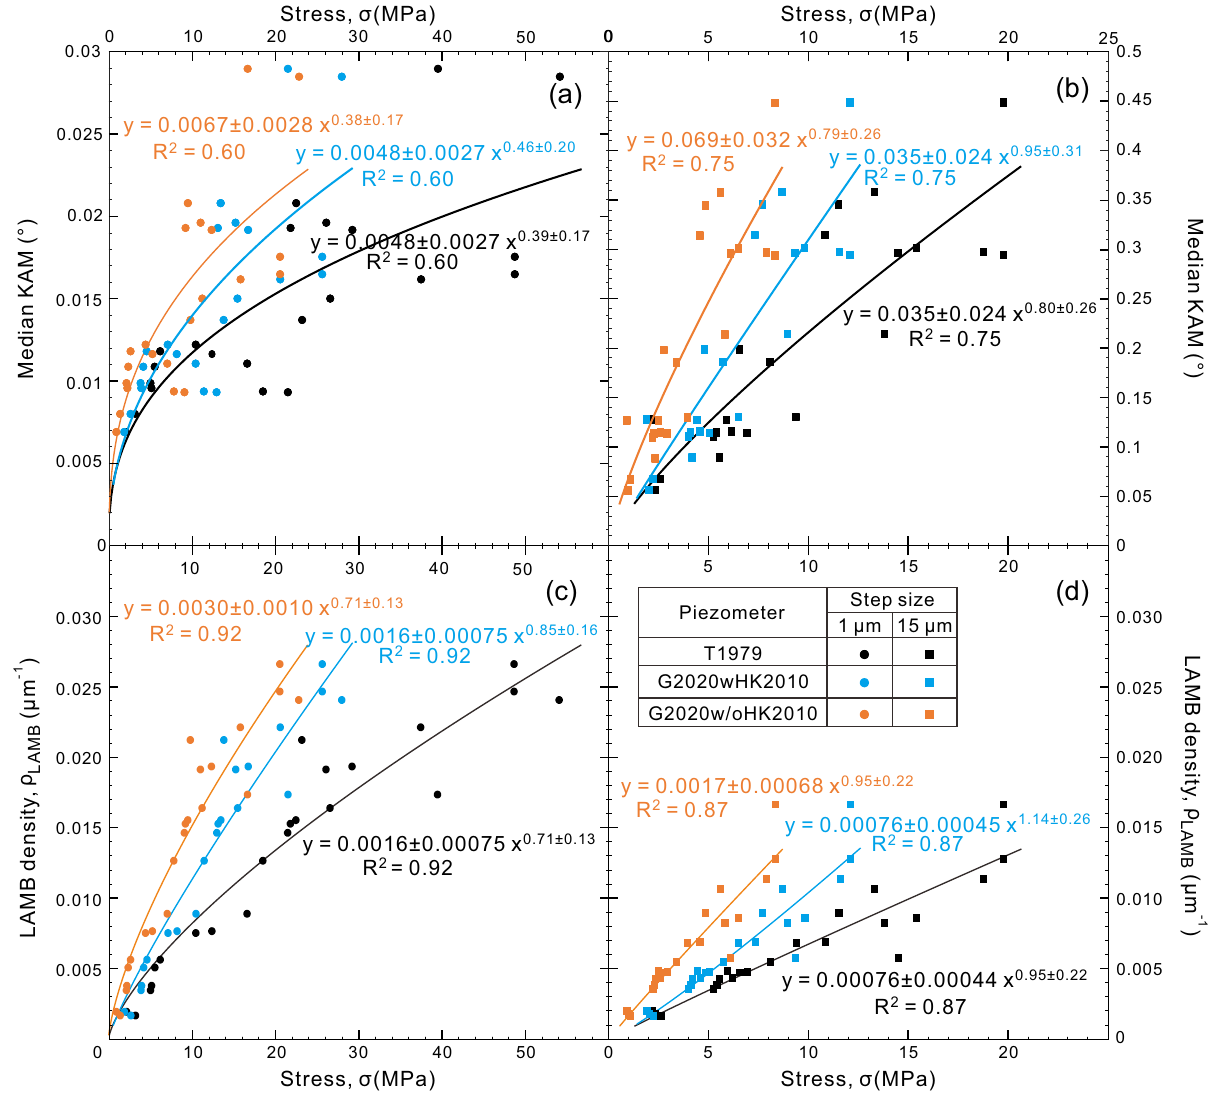
Figure 9. Relations between median KAM and stress ( a and b ) and between LAMB density and stress ( c and d ) for the 22 analyzed olivine grains at the step size of 1 μm (circles, left column) and 15 μm (rectangles, right column). The results of step size of 15 μm here are obtained by magnification from 1 μm (see Methods). Grain-3 has only one LAMB at the step size of 15 μm and its subgrain size cannot be calculated, this grain is thus excluded in stress estimation. Stress is estimated using the subgrain-size piezometers of T1979 (black), G2020wHK2010 (cyan) and G2020w/oHK2010